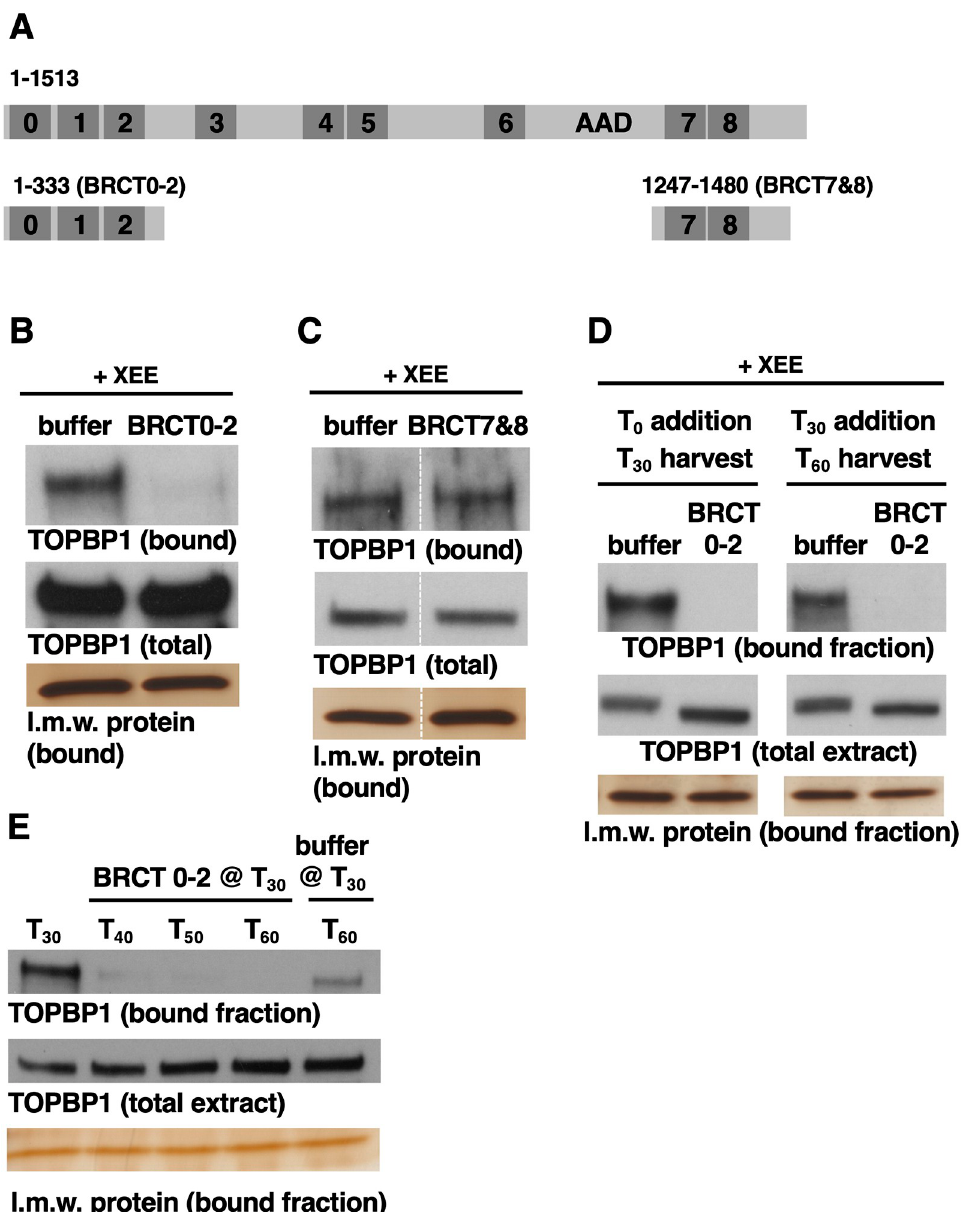
Fig 2. TOPBP1’s residency on DSBs is short-lived. A. A cartoon depicting full-length TOPBP1 and the two smaller fragments that were used in this experiment. B. A DSB-binding assay was performed under conditions where either buffer (PBS) or 1uM T7-6His-TOPBP1 BRCT0-2 was added to the XEE prior to addition of DSB beads. After incubation with DSB beads the beads were isolated, washed, and the samples were probed for TOPBP1. “Bound” refers to the DSB- bound material. “Total” refers to total extract, where 1 ul of the XEE used for these samples was probed for TOPBP1. The bottom panel is a silver stain gel of low molecular weight proteins bound to the DSBs, which serve as a control for equal isolation of the beads. The experiment shown is representative of two independently performed biological replicates. C. Same as (B) except T7-6His-TOPBP1 BRCT7&8 was used. The experiment shown is representative of two independently performed biological replicates. D. A DSB binding assay was performed where 1 uM T7-6His-TOPBP1 BRCT0-2 was added to the XEE either at the beginning of the experiment, at the same time as the DSB beads (T 0 addition), or 30 minutes after addition of DSB beads (T 30 addition). The beads were isolated at the indicated times and probed for TOPBP1 occupancy. The experiment shown is representative of two independently performed biological replicates. E. A DSB binding assay was performed where DSB beads were added at the beginning of the experiment (for all samples) and then isolated after 30 minutes (lane 1), 40 minutes (lane 2), 50 minutes (lane 3), or 60 minutes (lanes 4 and 5). 1 uM T7- 6His-TOPBP1 BRCT0-2 was added to samples 2–4 at 30 minutes. Sample 5 received buffer (PBS) at 30 minutes. The experiment shown is representative of two independently performed biological replicates.